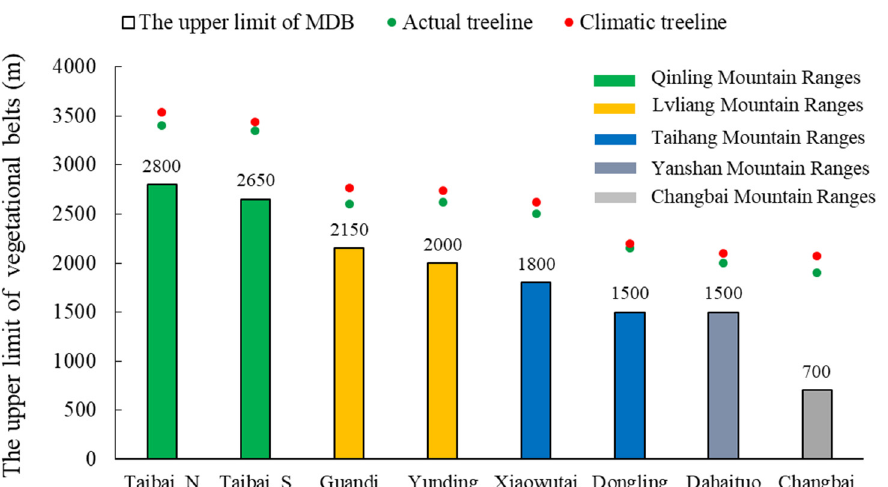
Figure 1. The upper limit of montane deciduous broad-leaved forest in the east monsoon realm of China. Abbreviation: UMDB (I), 8 upper limits of deciduous broad-leaved forest on the mountains with climatic treeline; TMDB (II), 45 upper limits of deciduous broad-leaved forests on the temperate mountains without climatic treeline; SMDB (II), 22 upper limits of deciduous broad-leaved forest on the subtropical mountains without climatic treeline.